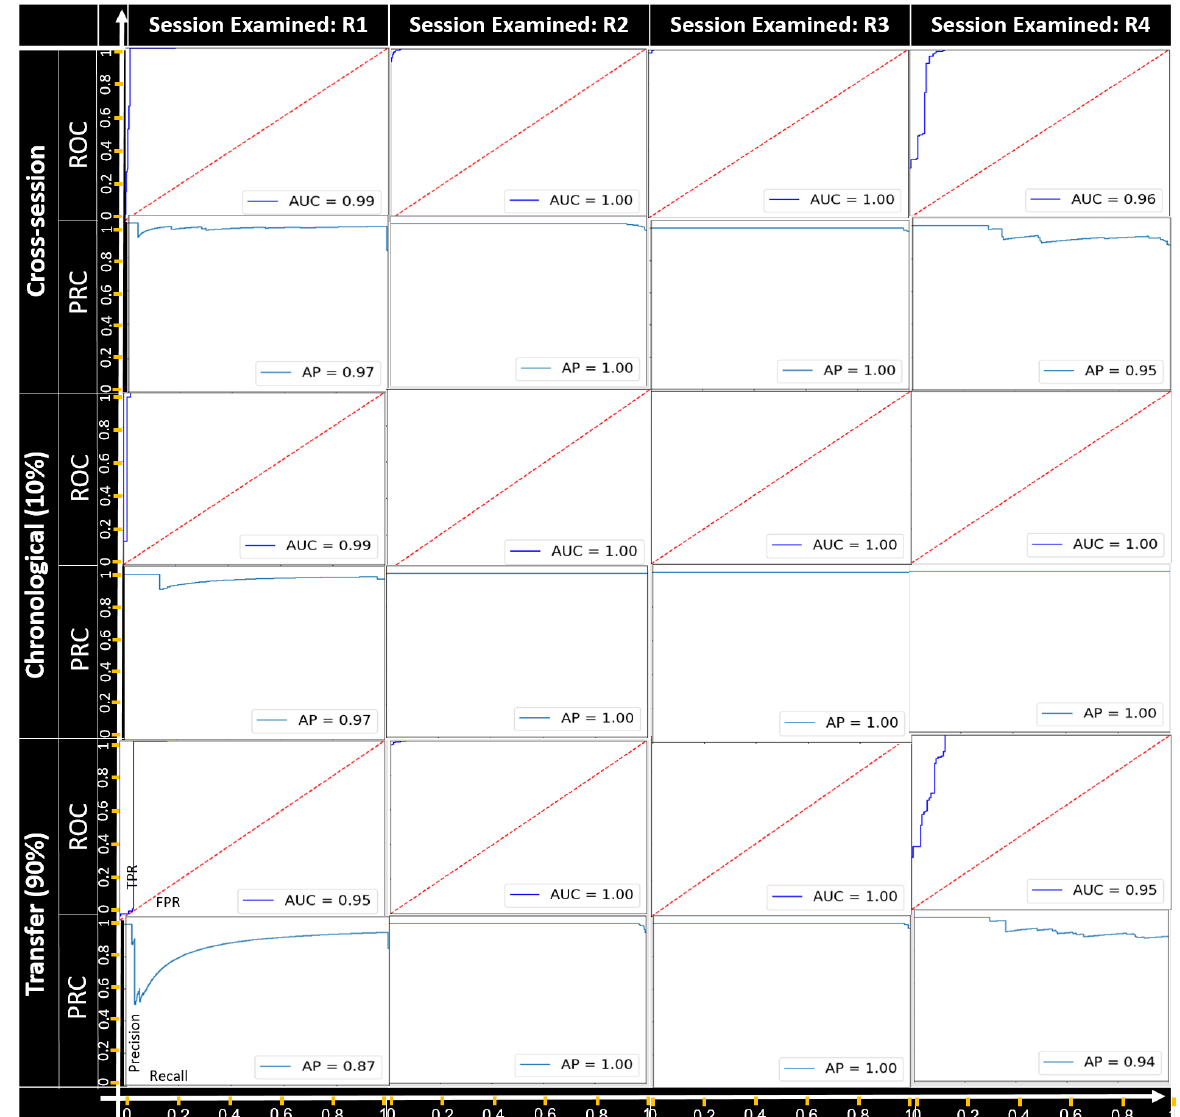
Figure 6. The ROC and PRC curves for the objectCategory feature-manipulation attack for each recording session